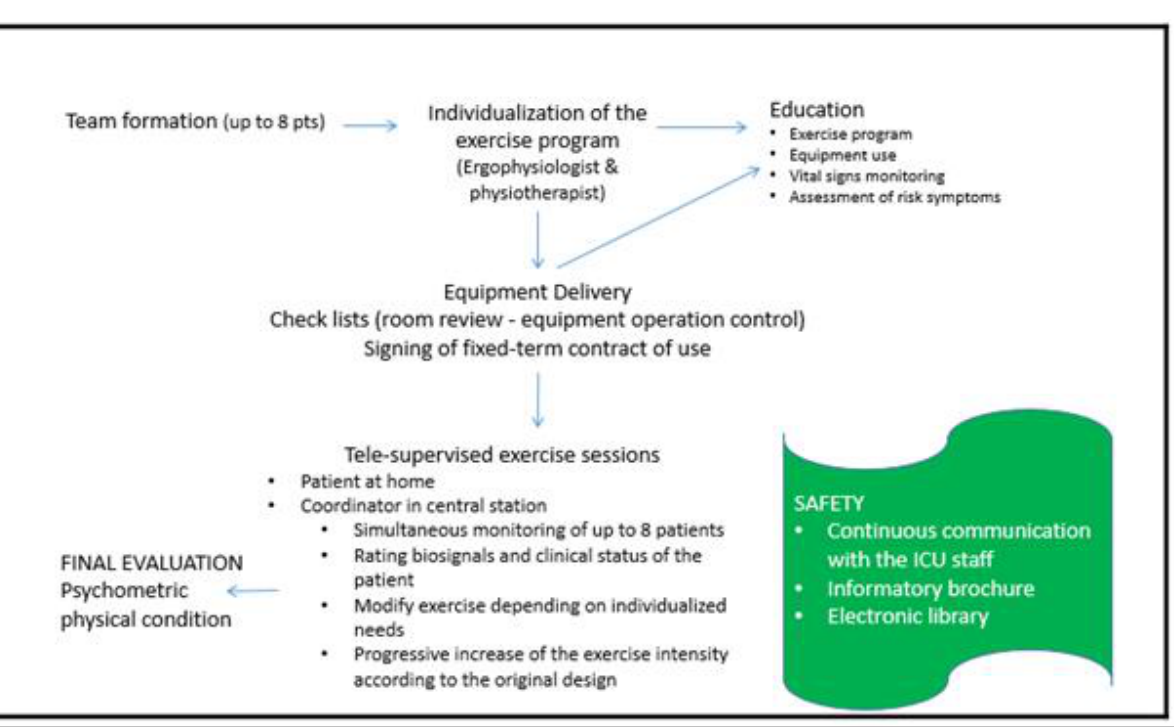
Figure 1. Diagram of the Nicosia General Hospital telerehabilitation